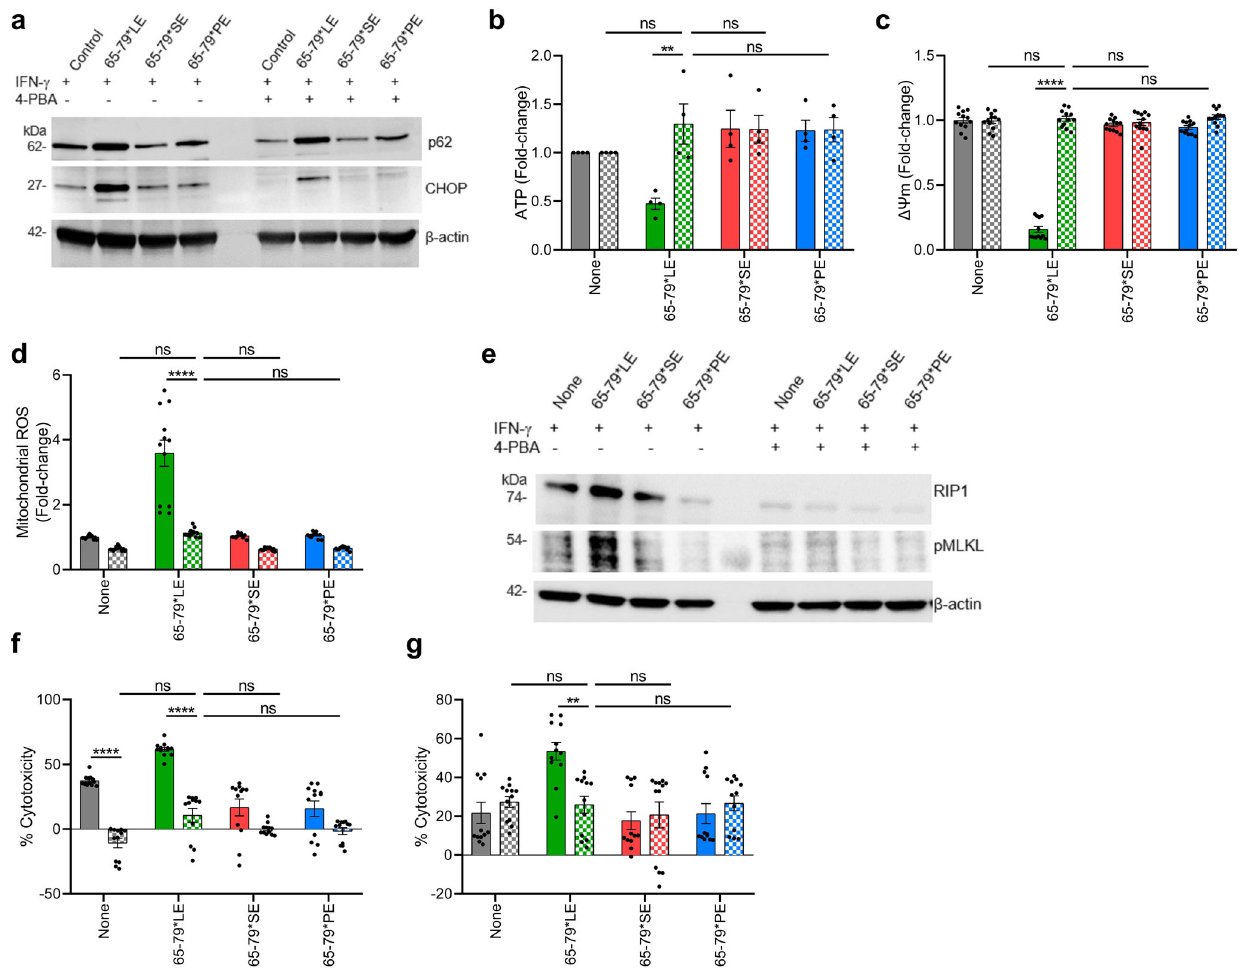
Fig. 6 LE-activated mitochondrial dysfunction is ER stress-dependent. a Immunoblots of CHOP and p62 in allelic epitope-treated RAW 264.7 macrophages in the presence (dotted bars) or absence (solid bars) of the ER stress inhibitory chemical 4-PBA (5 mM). b , d Intracellular ATP levels b , mitochondrial membrane potential c , and mitochondrial ROS levels d , in RAW 264.7 macrophages in the presence (dotted bars) or absence (solid bars) of 4-PBA ( n = 3). e Immunoblots of RIP1 and pMLKL in allelic epitope-treated RAW 264.7 macrophages in the presence (dotted bars) or absence (solid bars) of 4-PBA. f , g Cell death in allelic epitope-treated RAW 264.7 f , and THP-1 g , macrophages in the presence (dotted bars) or absence (solid bars) of 4-PBA ( n = 3). Blots ( a , e ) are each a representative of 3 independent experiments. Uncropped immunoblots are shown in Supplementary Fig. S9. Data represent mean ± SEM. Two-way ANOVA, ** p < 0.01, **** p < 0.0001. See also Supplementary Fig.